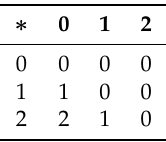
Table 3. Cayley table for the binary operation “ ∗